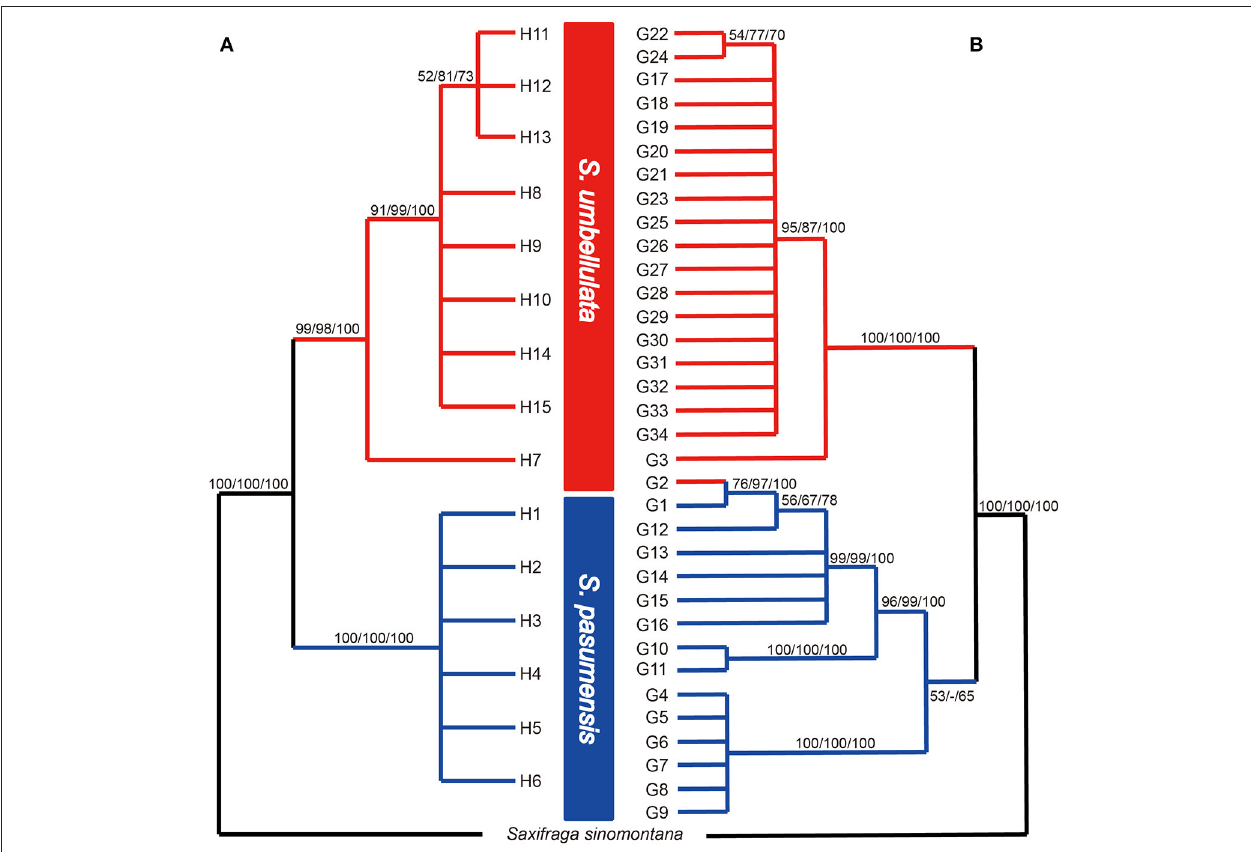
FIGURE 3 | Fifty percent strict consensus trees based on cpDNA haplotypes (A) and ITS genotypes (B) of Saxifraga pasumensis s.l. and S. umbellulata . Numbers on the branches are bootstrap values from maximum parsimony (left) and maximum likelihood (middle) analyses and posterior probabilities (right) from Bayesian inference.